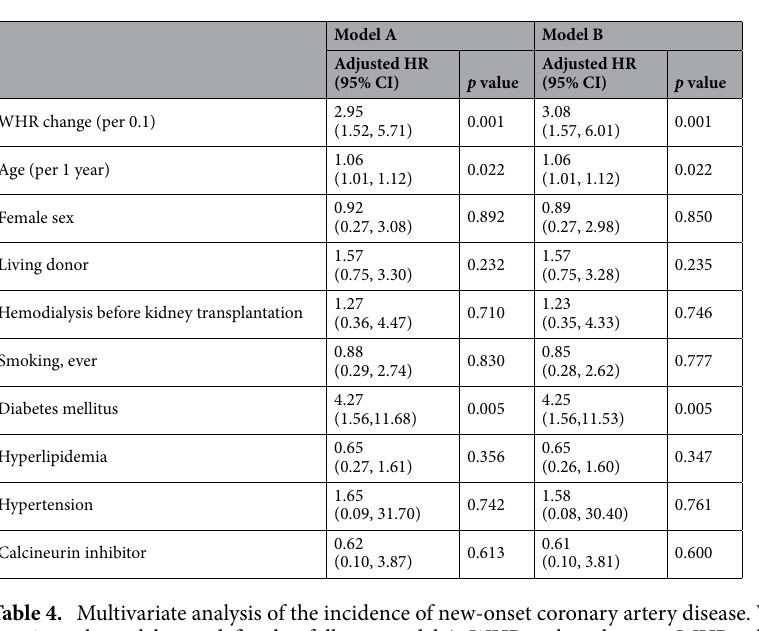
Table 4. Multivariate analysis of the incidence of new-onset coronary artery disease. WHR changes at the nth year in each model were defined as follows: model A: WHR at the nth year—WHR at baseline. model B: WHR at the nth year—WHR at the (n − 1)th year.